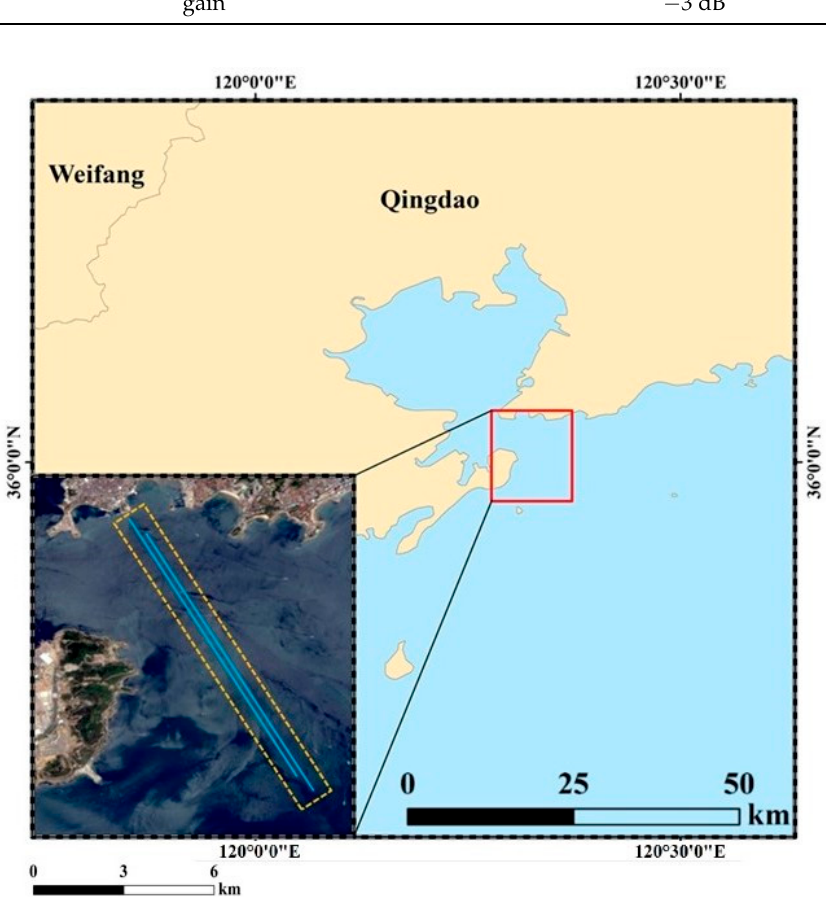
Figure 2. The Jiaozhou Bay area. The red rectangle indicates the trial area and the blue line indicates the survey line.